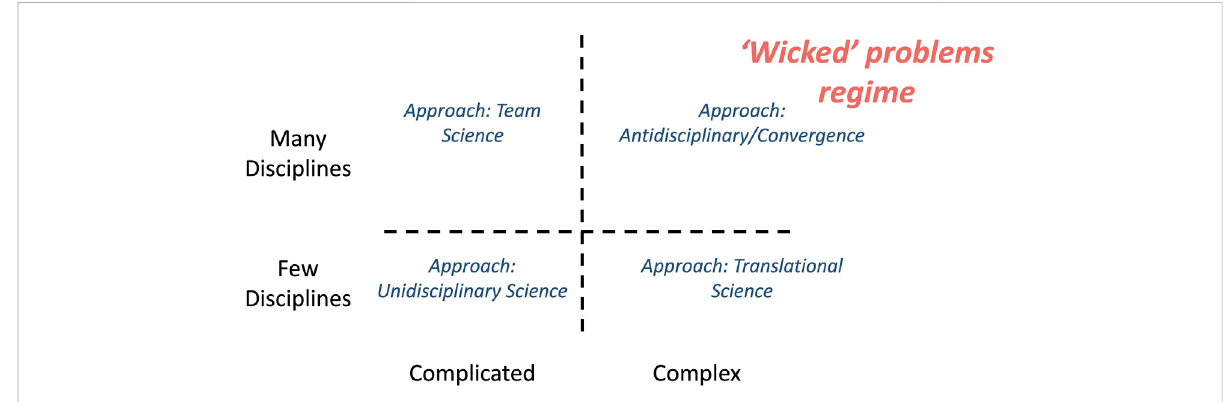
FIGURE 1 An illlustration of the problemscape and approaches of the Earth and Space